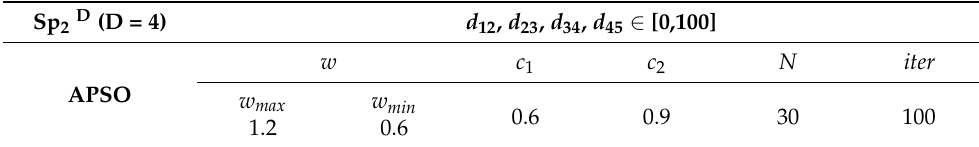
Table 3. Secondary particle search range of transmission